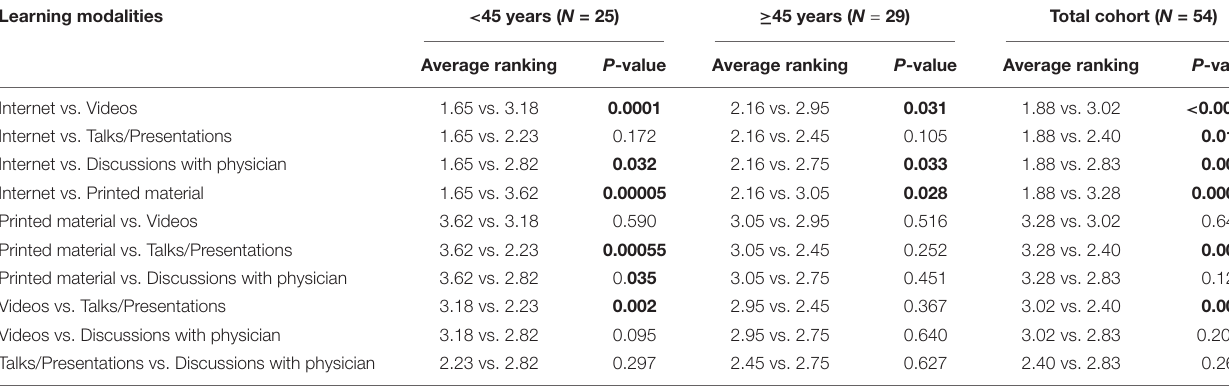
TABLE 2 | Mann-Whitney U- test analysis evaluating preferences of specific learning modalities for genetic education. Learning